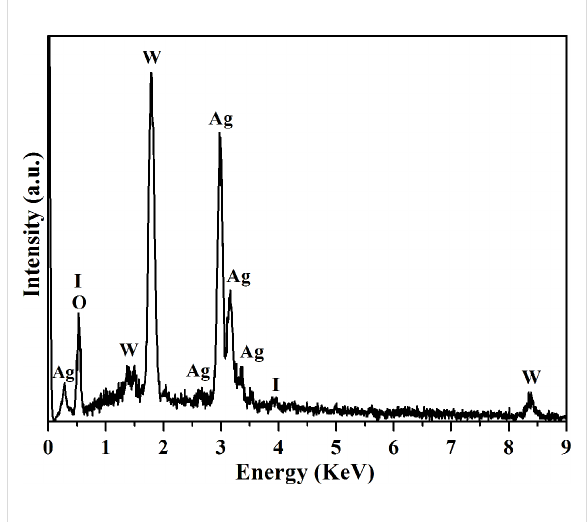
Figure 3: Energy-dispersive X-ray (EDX) spectrum of 0.3AgI/Ag 2 WO 4